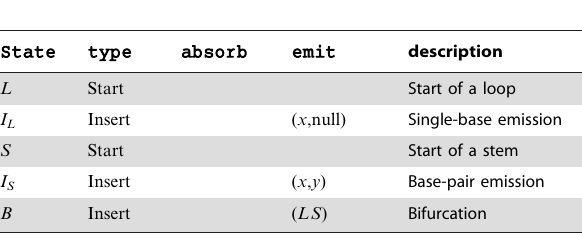
Table 3. State types of the branch transducer (conditionally- normalized Pair SCFG) of the TKF Structure Tree